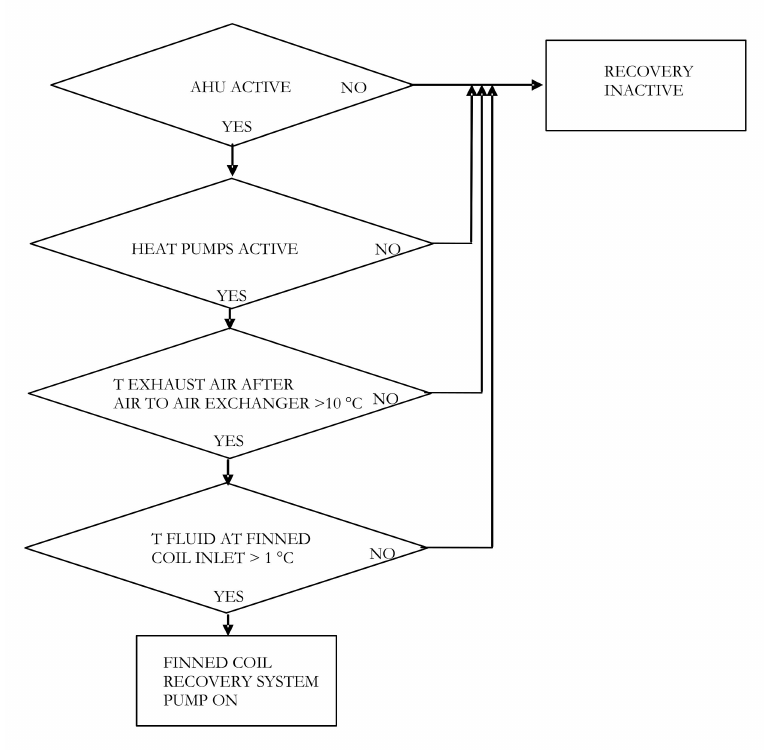
Figure 5. Flow diagram for ventilation recovery control system.